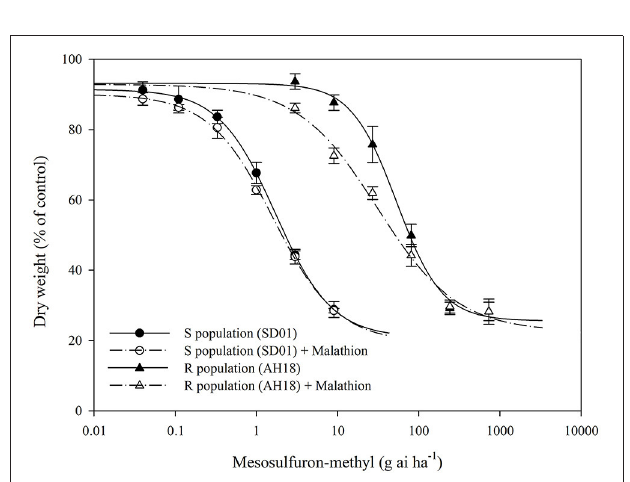
FIGURE 2 | Dose-response curves for the dry weight of the R (AH18) and S (SD01) Alopecurus aequalis populations treated with a range of mesosulfuron-methyl doses with ( + ) or without 1,000 g ai ha − 1 of malathion. The values are expressed as the percentage of the untreated control. Each data point is the mean ± SE of twice-repeated experiments. The lines were fitted to the mean values using “four-parameter log-logistic equation”.